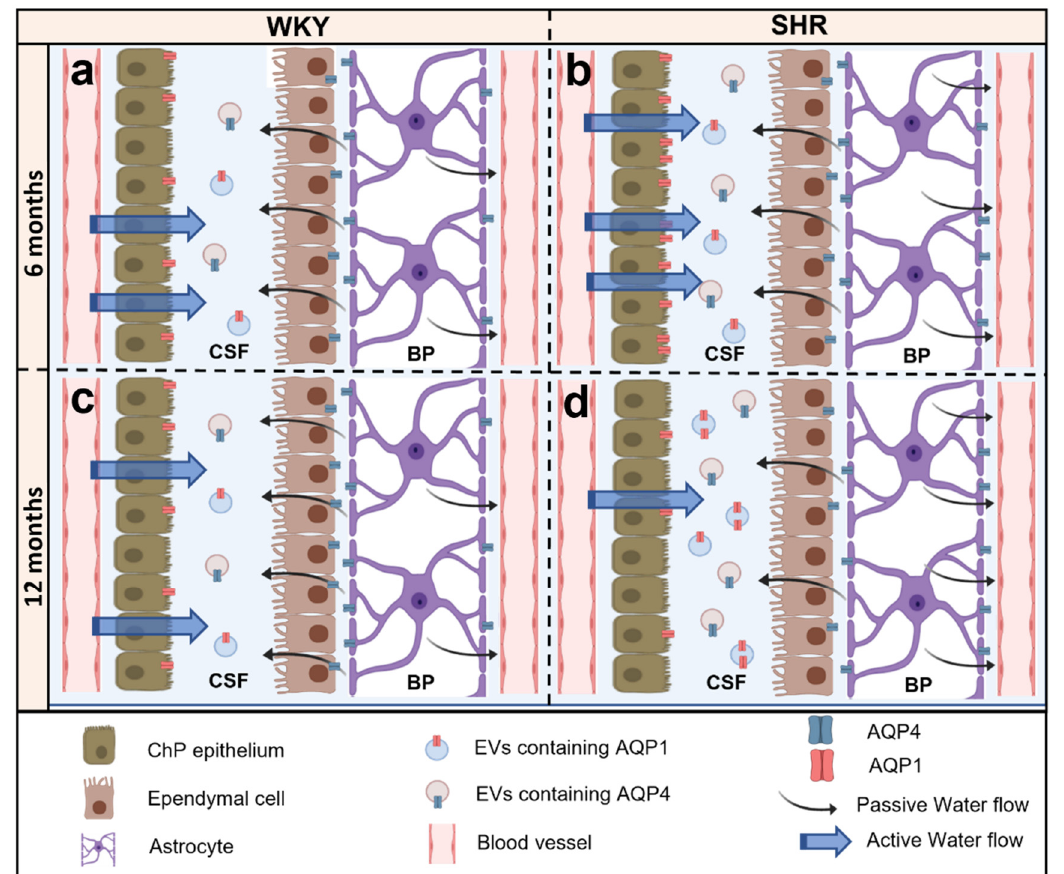
Figure 5. Schematic representation of the expression of AQP1 and AQP4 in 6 months and 12 months WKY and SHR rats. In 6 months and 12 months WKY ( a , c ), rat expression of AQP 1 is detected in the apical pole of the ChP epithelium associated with active production of CSF. It is also found in the CSF, most likely associated with EVs. Per contra, AQP4 is expressed in the astrocyte end ‐ feet and the basolateral membrane of the ependymal cells associated with brain CSF homeostasis. In addition, it is found in the CSF. In 6 months SHR rats ( b ), AQP1 expression is significantly increased in the apical pole of the ChP epithelium, and AQP4 expression increases in the astrocytes end ‐ feet but not in the ependymal cells. This AQP disbalance may contribute to the mechanisms that trigger ventriculomegaly. In the CSF, the expression of AQPs remains the same as in 6 months WKY. In the 12 months SHR rats ( d ), AQP1 expression significantly decreased in the ChP epithelium while pro ‐ portionally increasing in the CSF compared to 12 months WKY ( c ). Thus, it could reduce CSF pro ‐ duction as a possible compensatory mechanism for ventriculomegaly. In turn, AQP4 decreased in the ependymal layer while it increased in the CSF and in the astrocytes’ end ‐ feet, which could also contribute to reducing the production of CSF (ependymal layer) and the increase of the CSF absorp ‐ tion (astrocyte end ‐ feet).